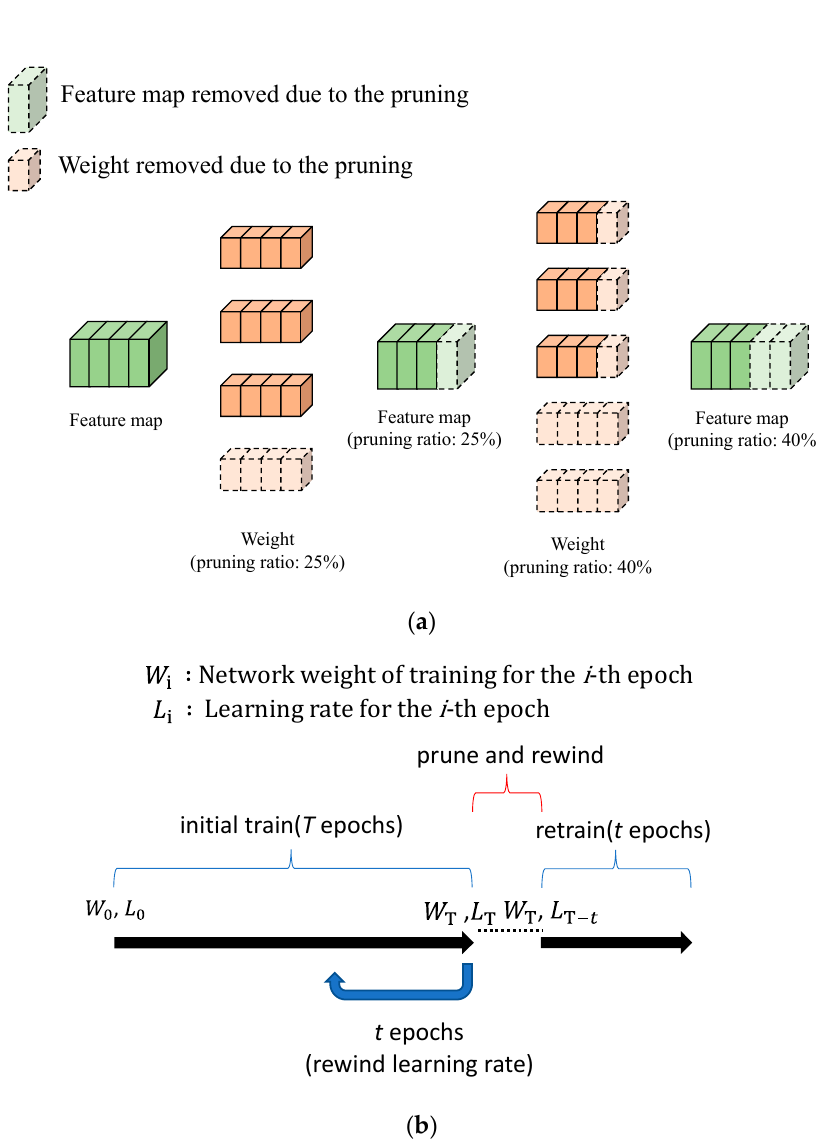
Figure 9. Pruning and retraining schematic: ( a ) structural pruning; ( b ) learning rate rewinding.